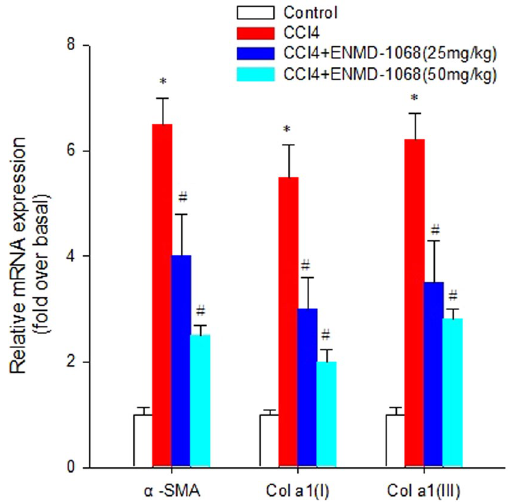
Figure 4. ENMD-1068 inhibits the mRNA expression of fibrotic marker in liver tissues. Mice were divided into 4 groups randomly. Control mice were treated with olive oil only. Mice in CCl 4 group received CCl 4 twice per week. In ENMD-treated group, mice were administered intraperitoneally 25 mg/kg or 50 mg/kg ENMD-1068 15 mins before CCl 4 treatment twice per week for 4 weeks. All animals were sacrificed at 4 weeks after CCl 4 treatment and liver tissues were co llected to investigate the effect of ENMD-1068 on the mRNA expression of fibrotic marker. The mRNA expression of fibrotic markers was quantified using real-time RT-PCR. 18 S rRNA was used for normalization of PCR data for the genes of α -SMA, Col α 1(I) and Col α 1(III). N = 6, bars represent SD, * P < 0.05 vs Control, # P < 0.05 vs CCl 4